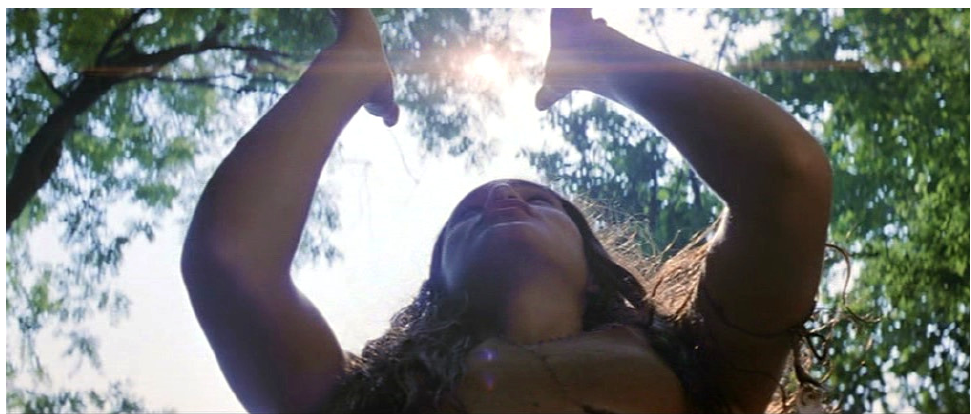
Figure 3: Pocahontas’ sky-directed salutation is framed to facilitate a union of sun, sky, and earth.